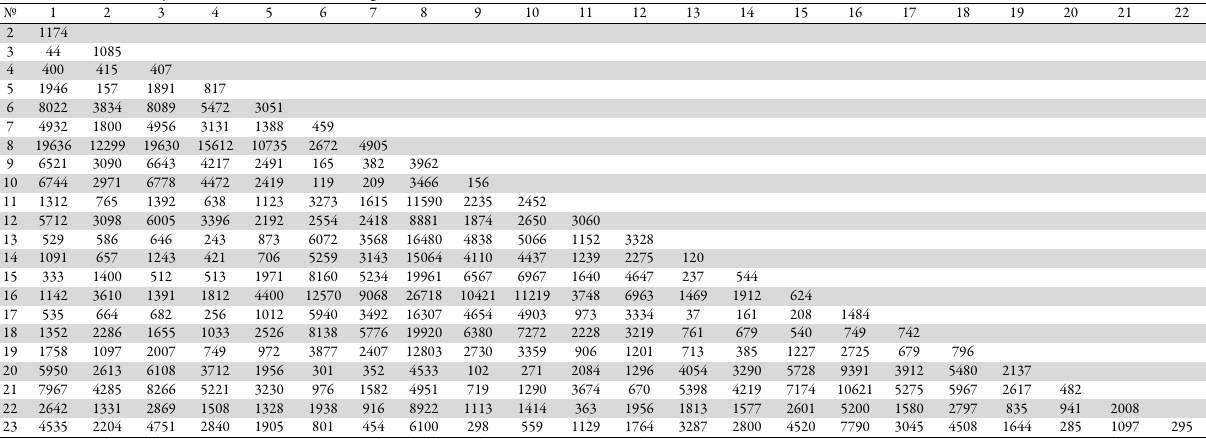
Table 3. Cluster analysis of 23 studied white lupine